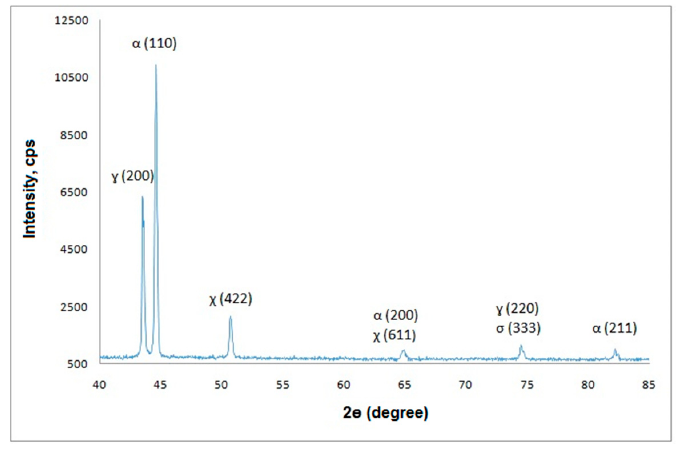
Figure 4. X-ray diffraction pattern of 2304 DSS HAZ.